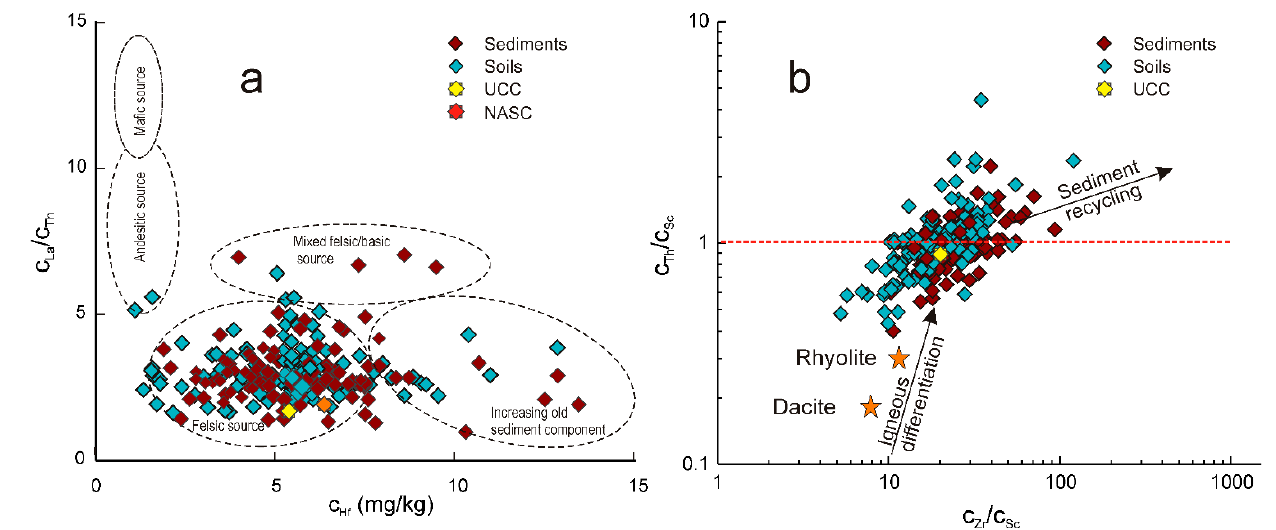
Figure 6. Discriminating bi-plot Th/Co vs. La/Sc ( a ); and ternary Sc-La-Th diagram ( b ) confirming the felsic origin of investigated sediments and soils.